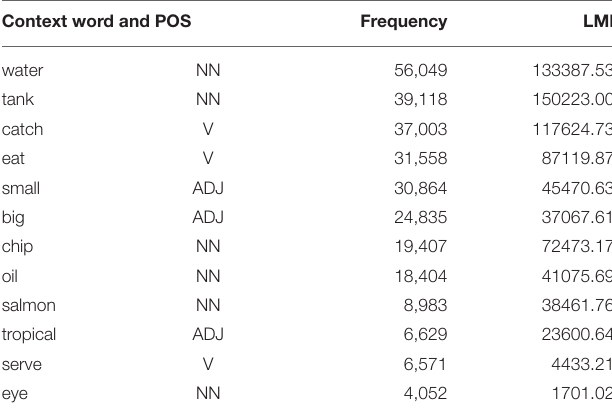
TABLE 1 | Sizes of vector space variants in terms of numbers of target types and dimension types in the co-occurrence (context) matrices. Target POS